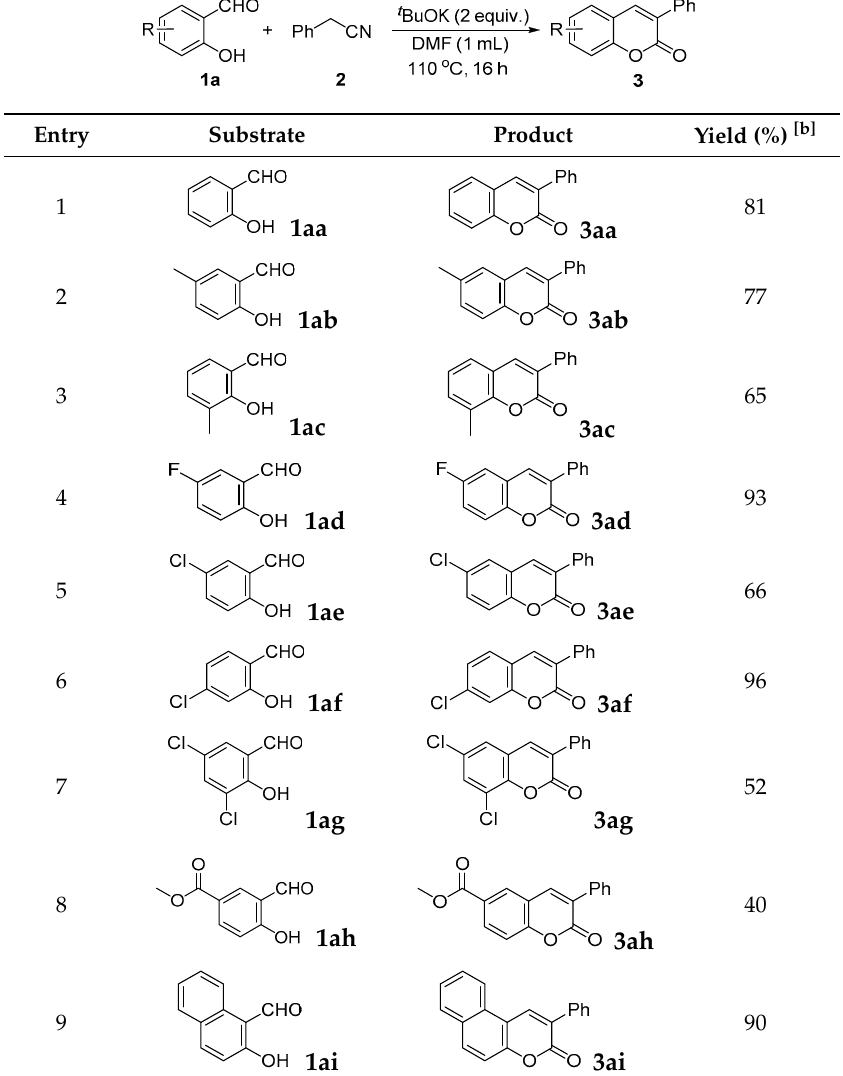
Table 2. Synthesis of chromenones from salicylaldehydes [a] .